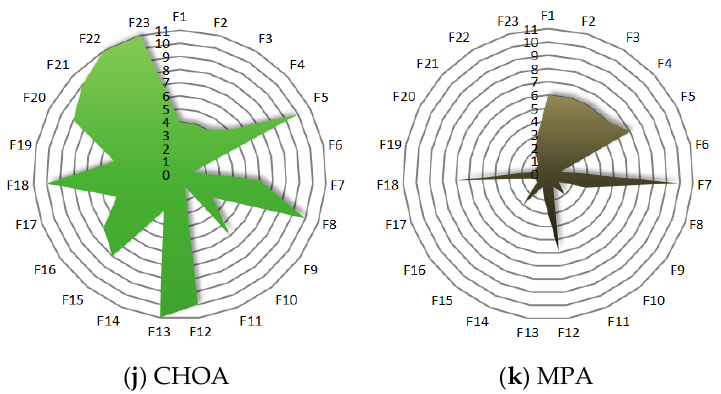
Figure 5. Radar charts of all 11 algorithms.